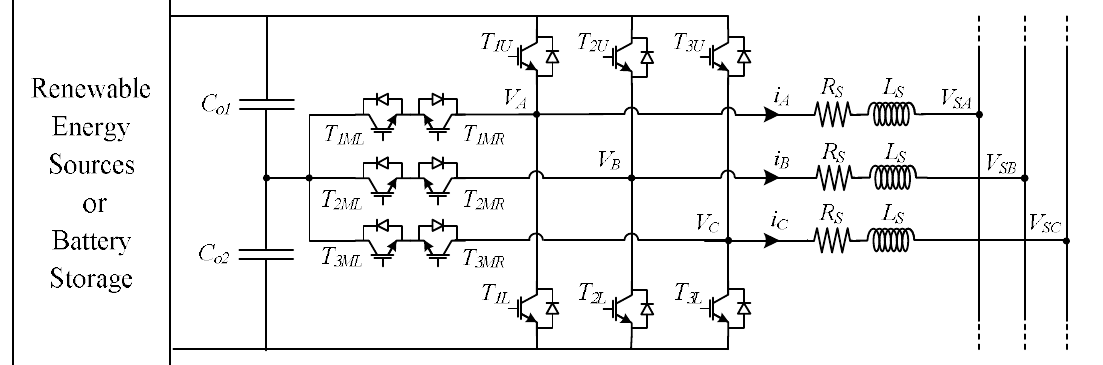
Figure 1. A typical solution for grid-connected renewable generators and storage systems in